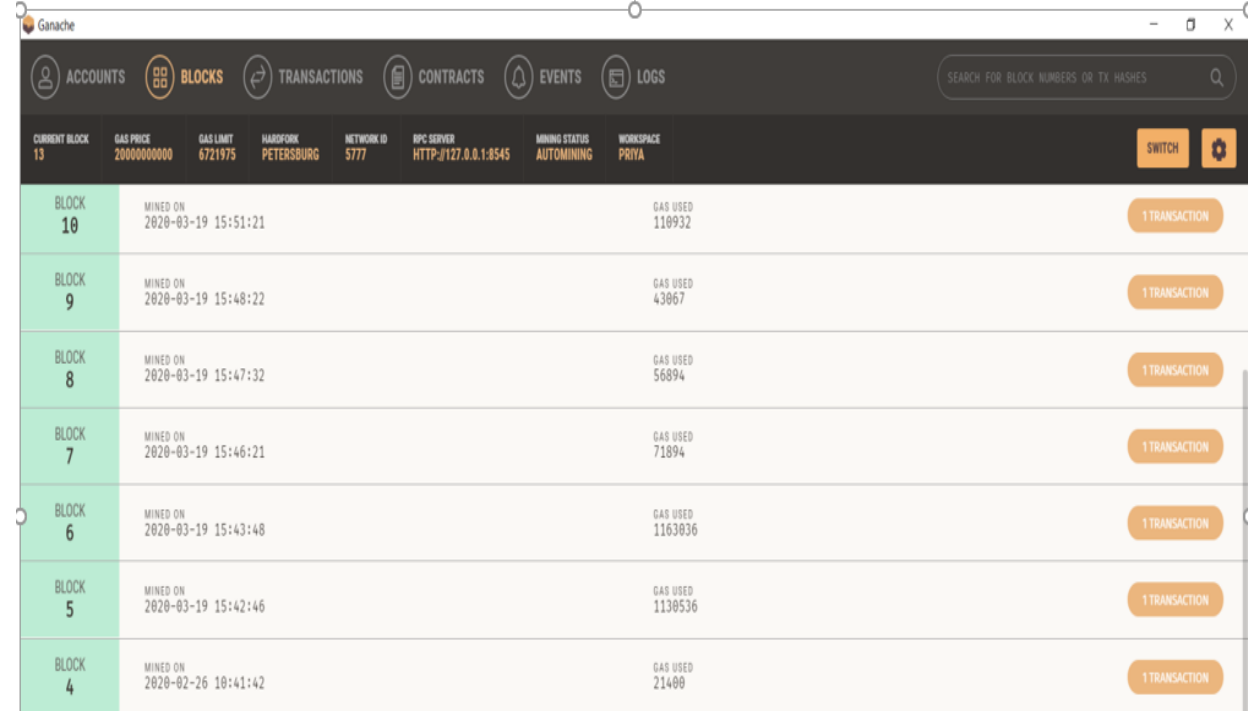
Figure 4. Transactions information in Ganache.